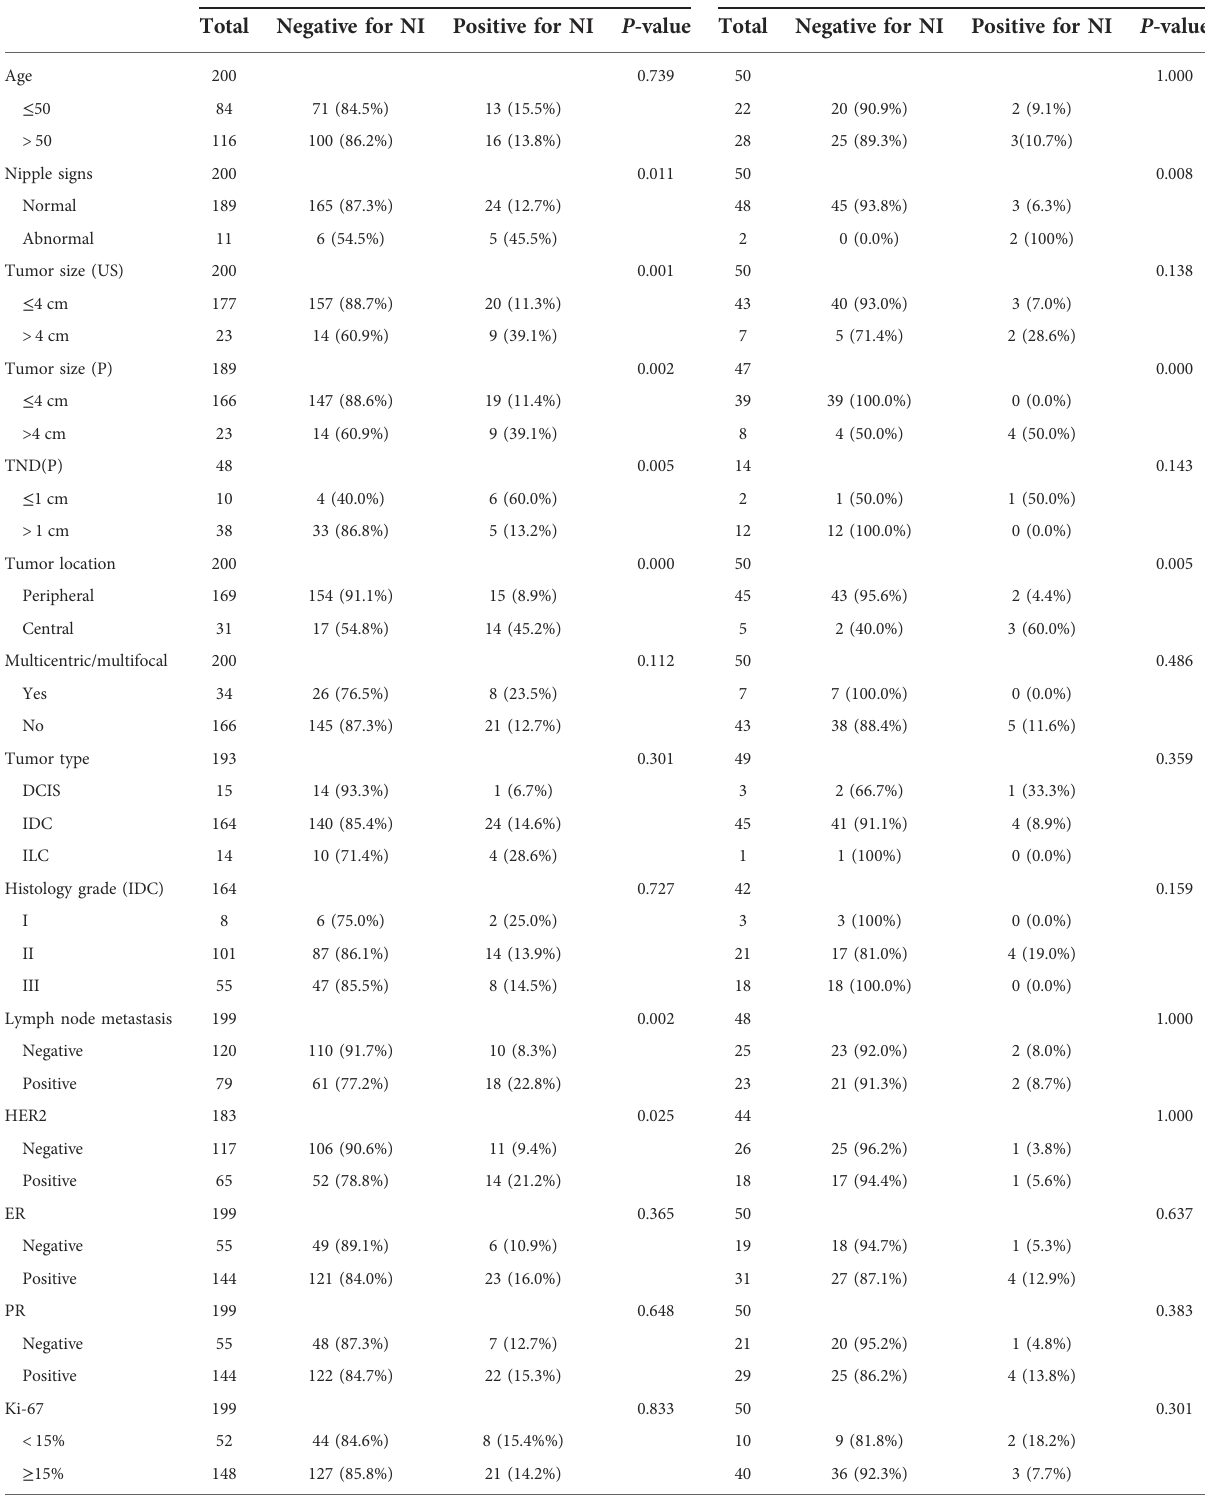
TABLE 1 Clinicopathologic characteristics of patients in the training and validation